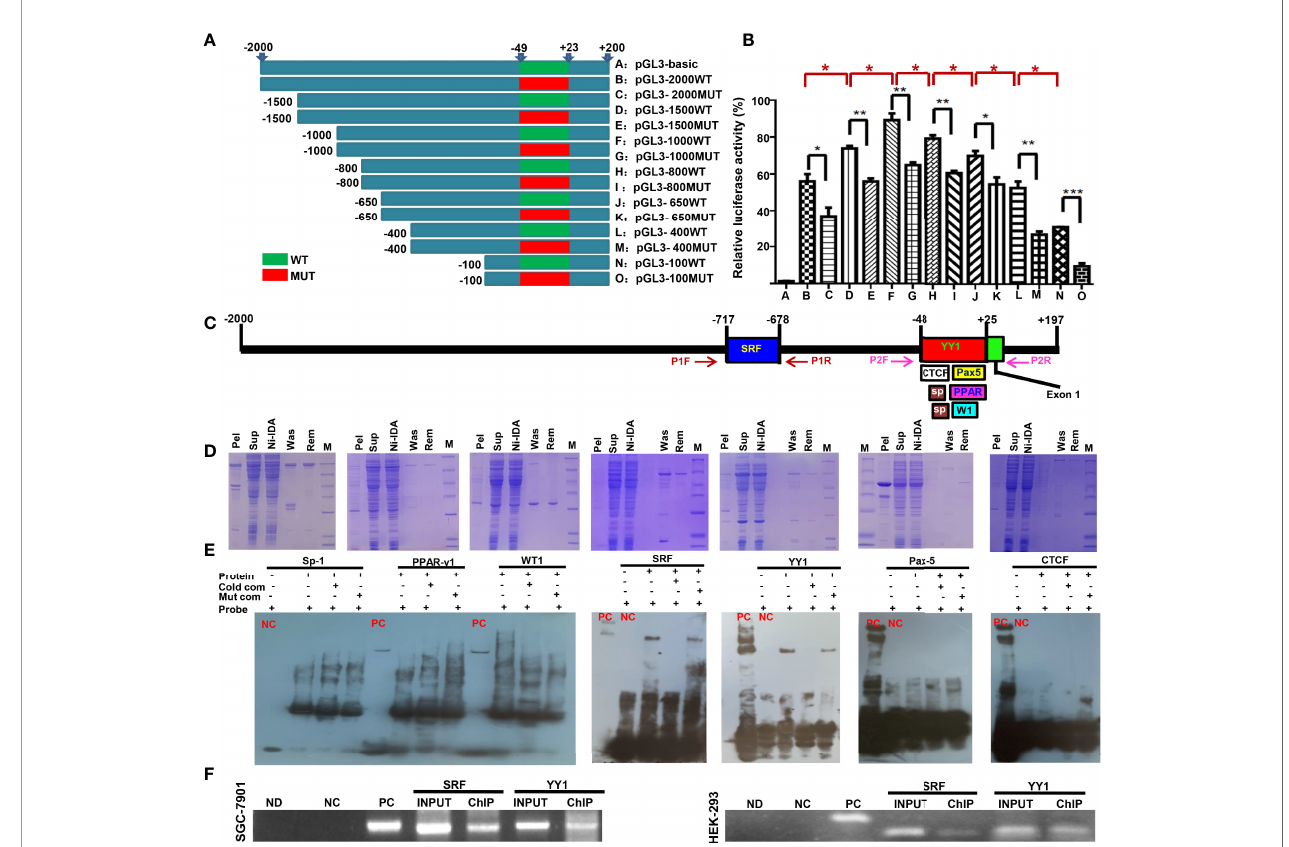
FIGURE 1 | The promoter activity and trans-acting factors of ING5 gene Different upstream wild-type (WT) and mutant (MUT) DNA fragments of ING5 were inserted into the pGL-3 basic vector, as shown schematically (A) . These plasmids and pRL-TK were co-transfected into HEK293 cells and the cell lysates were subjected to luciferase reporter assay (B) . We also predicted trans-acting factors that bind to the promoter of ING5 (C) . Among them, His-tagged Sp-1 (Sp), WT-1 (W1), PPAR- g 1 (PPAR), SRF, YY1, CTCF, and Pax5 expression plasmids were constructed using pET-28 vector, induced by IPTG, and puri fi ed by Ni-IDA (D) . In EMSA, the recombinant proteins were incubated with probes and subjected to electrophoresis (E) . To con fi rm the EMSA results, we carried out ChIP in SGC-7901 and HEK293 cells using either anti-SRF or anti-YY1 antibody (F) . M, marker; pel, pellet after sonication; sup, supernatant after sonication; Ni-IDA, supernatant throughout Ni-IDA column; Was, washed target protein; Rem, remnant protein in column; NC, negative control; PC, positive control; cold com, cold competitor; Mut com, mutant competitor; ChIP, chromatin immunoprecipitation; Ctr, control; ND, no DNA; NC in ChIP, negative control using normal mouse IgG ChIP; PC in ChIP, positive control using anti-Pol II ChIP; INPUT, 2%